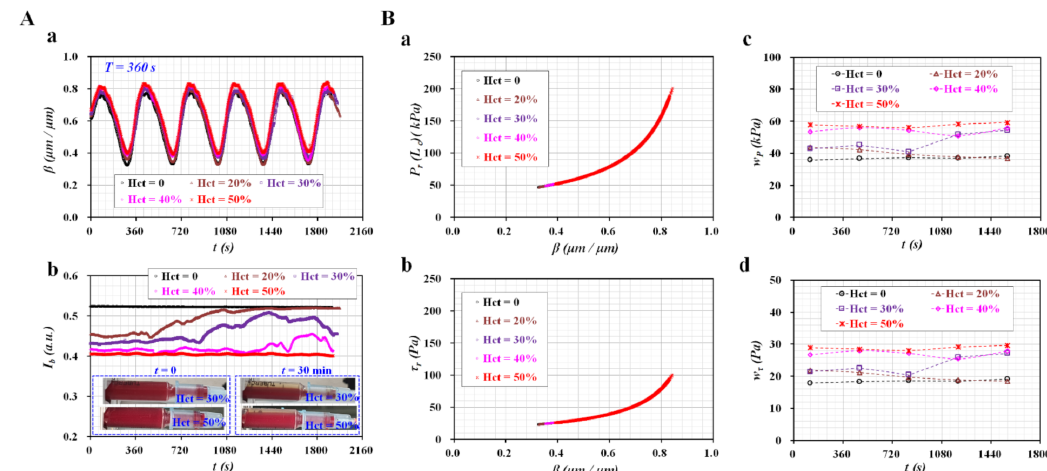
Figure 7. Contribution of hematocrit to four parameters (i.e., P r , τ r , w P , and w τ ) under sinusoidal blood flow. Glycerin solution (20%) as the reference fluid was supplied at the flow rate of 0.5 mL/h. Hematocrit of blood was adjusted to Hct = 0, 20%, 30%, 40%, and 50% by adding normal RBCs into plasma. After a disposable syringe filled with blood was installed horizontally, blood as test fluid was delivered at the flow rate of Q t = 0.9 + 0.7 sin (2 × π × t /360) mL/h. ( A ) Temporal variations of β and I b with respect to Hct. (a) Temporal variations of β with respect to Hct. (b) Temporal variations of I b with respect to Hct. Inset showed image of a driving syringe filled with blood (Hct = 30%, and 50%) captured at t = 0 and t = 30 min. ( B ) Variations of four factors ( P rs [ L c ], τ r , w P , and w τ ) with respect to Hct and β . (a) Variations of P r ( L c ) with respect to Hct and β . (b) Variation of τ r with respect to Hct and β . (c) Temporal variations of w P with respect to Hct. (d) Temporal variations of w τ with respect to